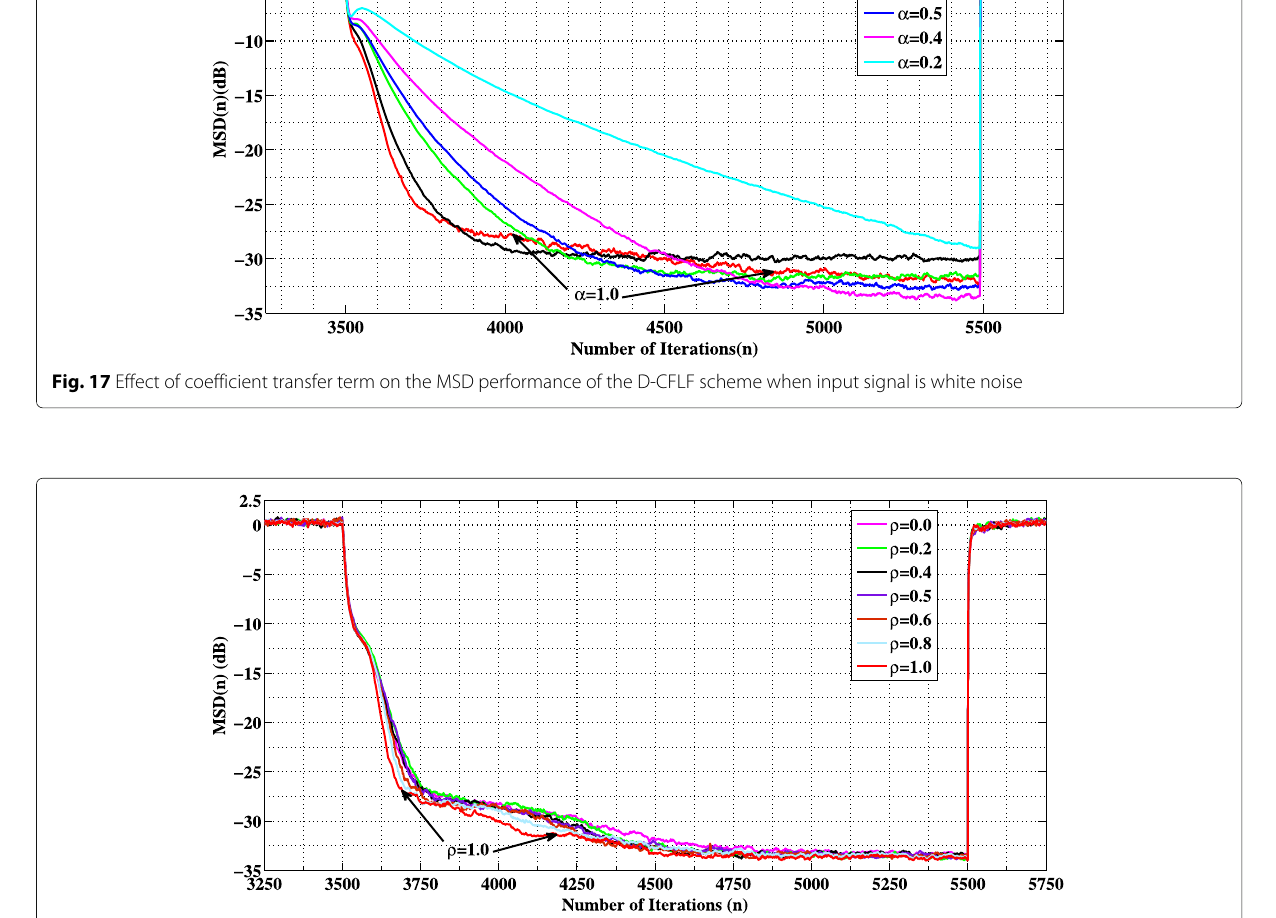
Fig. 18 Effect of momentum term on the MSD performance of the R-CFLF scheme when input signal is white